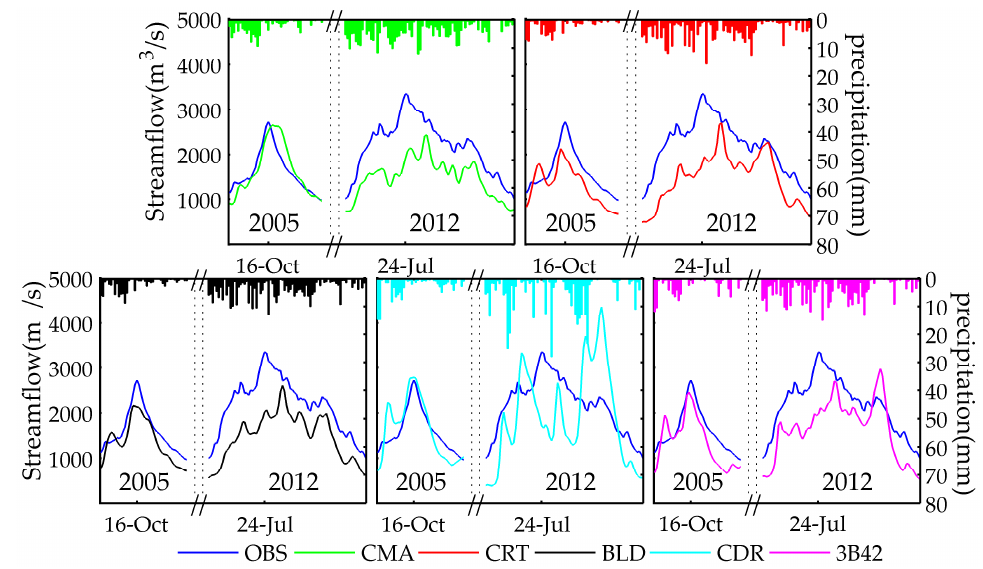
Figure 9. The observed and simulated streamflows for both the event 2005 and event 2012 flood scenarios.